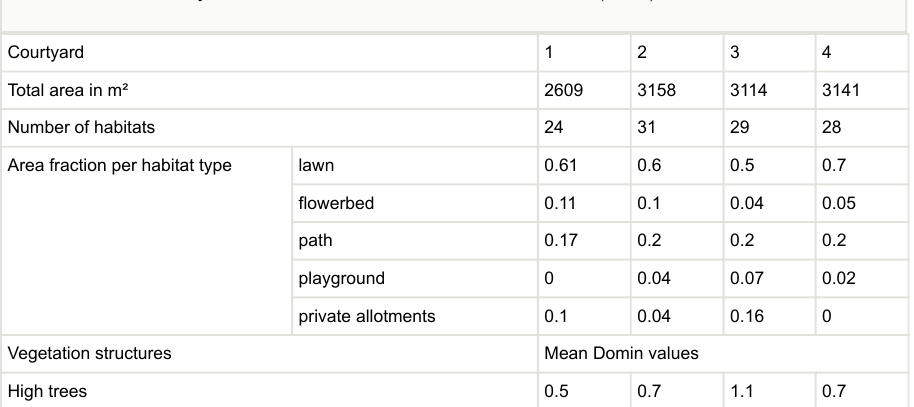
Results of biodiversity assessment, based on Tzoulas and James